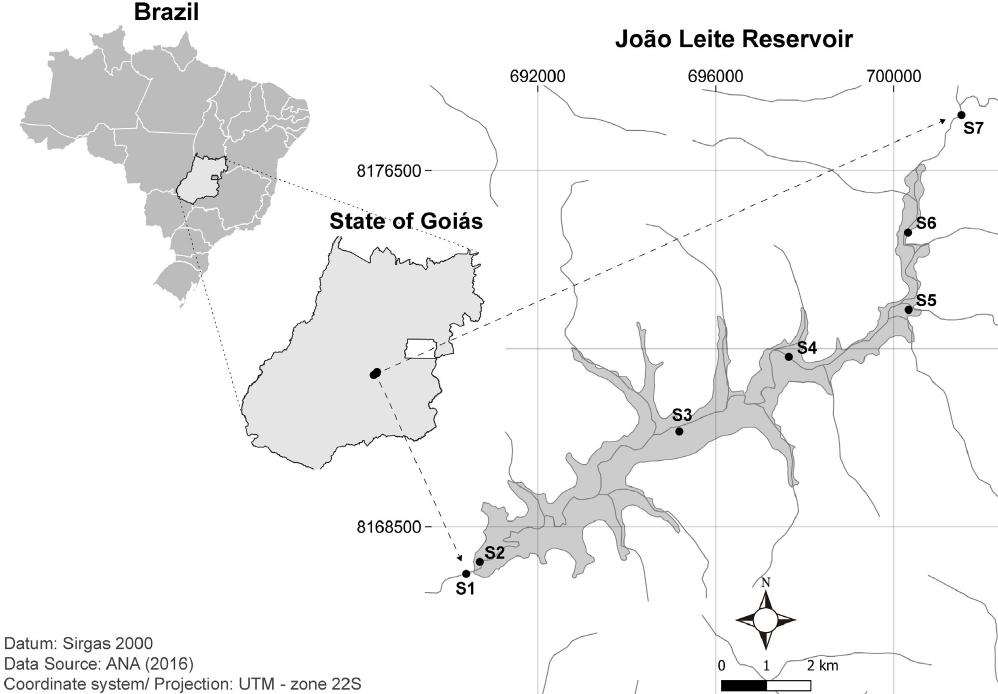
Figure 1. Map of the João Leite reservoir, GO, Brazil, and sampling sites (S1 - downstream; S2, S3 and S4 - lacustrine region; S5 and S6 - intermediate region; S7 - lotic